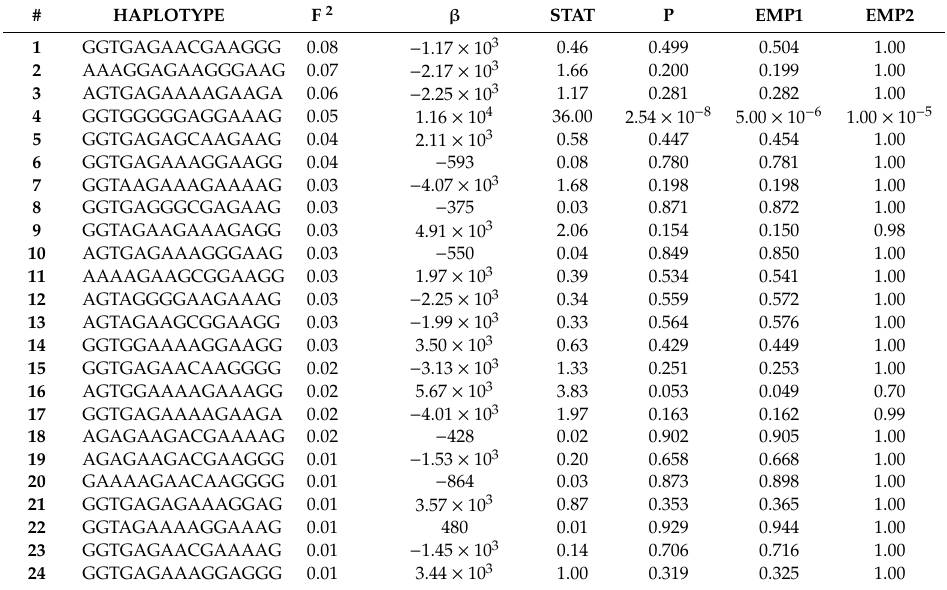
Table 1. Association of BTA3 haplotype alleles with CD18 leukocyte counts 1 .